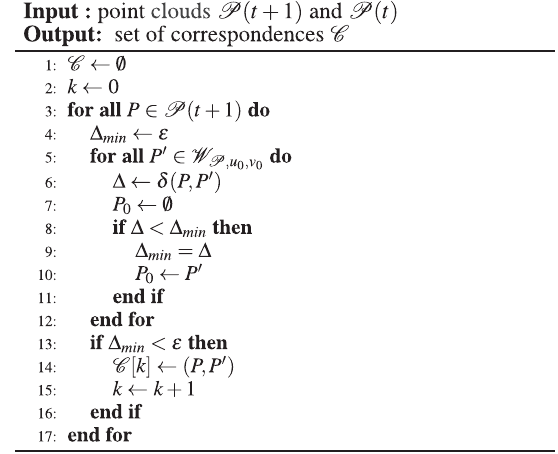
Algorithm 1. Correspondences searching between two ordered point clouds.